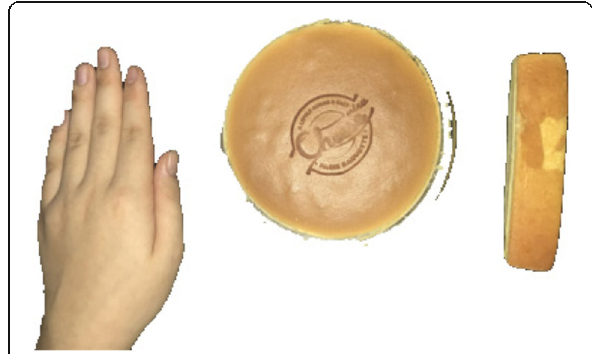
Fig. 5 Restoring images after Canny operator edge